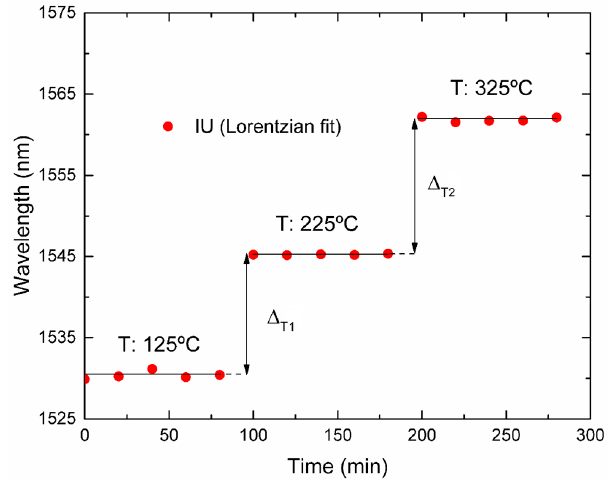
Figure 11. Wavelength shift of the dip of the LPFG when the temperature experiences step variations.